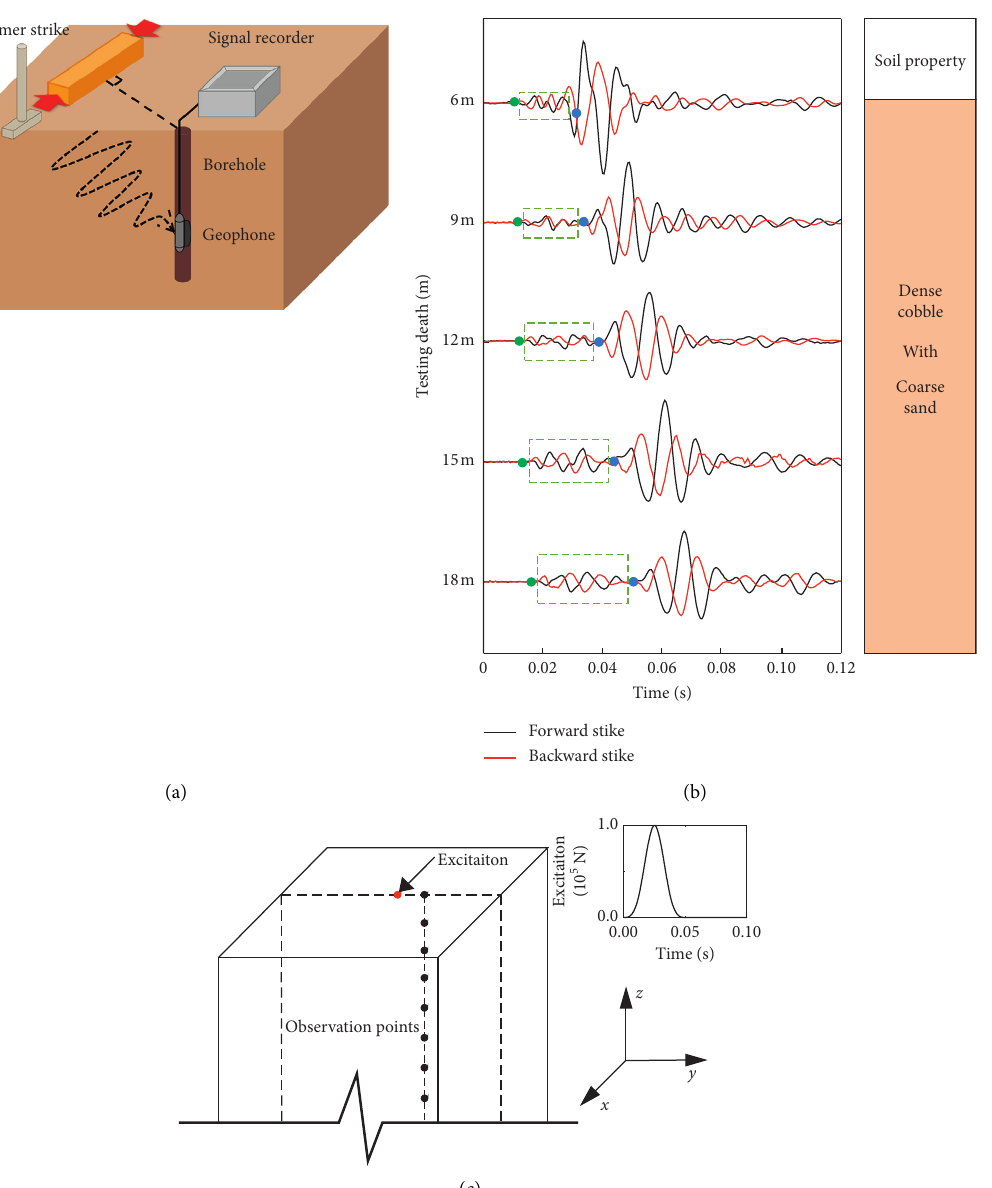
Figure 1: Downhole method. (a) Schematic of the downhole velocity test method with the surface plank source. (b) Signal traces recorded at different testing depth by the downhole method at a site in Beijing. (c) 3D numerical analysis model of size 16m × 16m ×